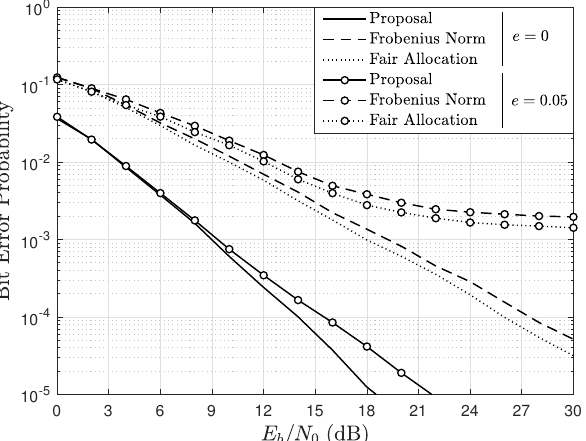
Figure 7. BER as a function of E b / N 0 , parameterized by e , and the scheduling algorithm considering BPSK modulation, A = 4, U = 4, U t = 5, and a channel with Rician factor K = 2.